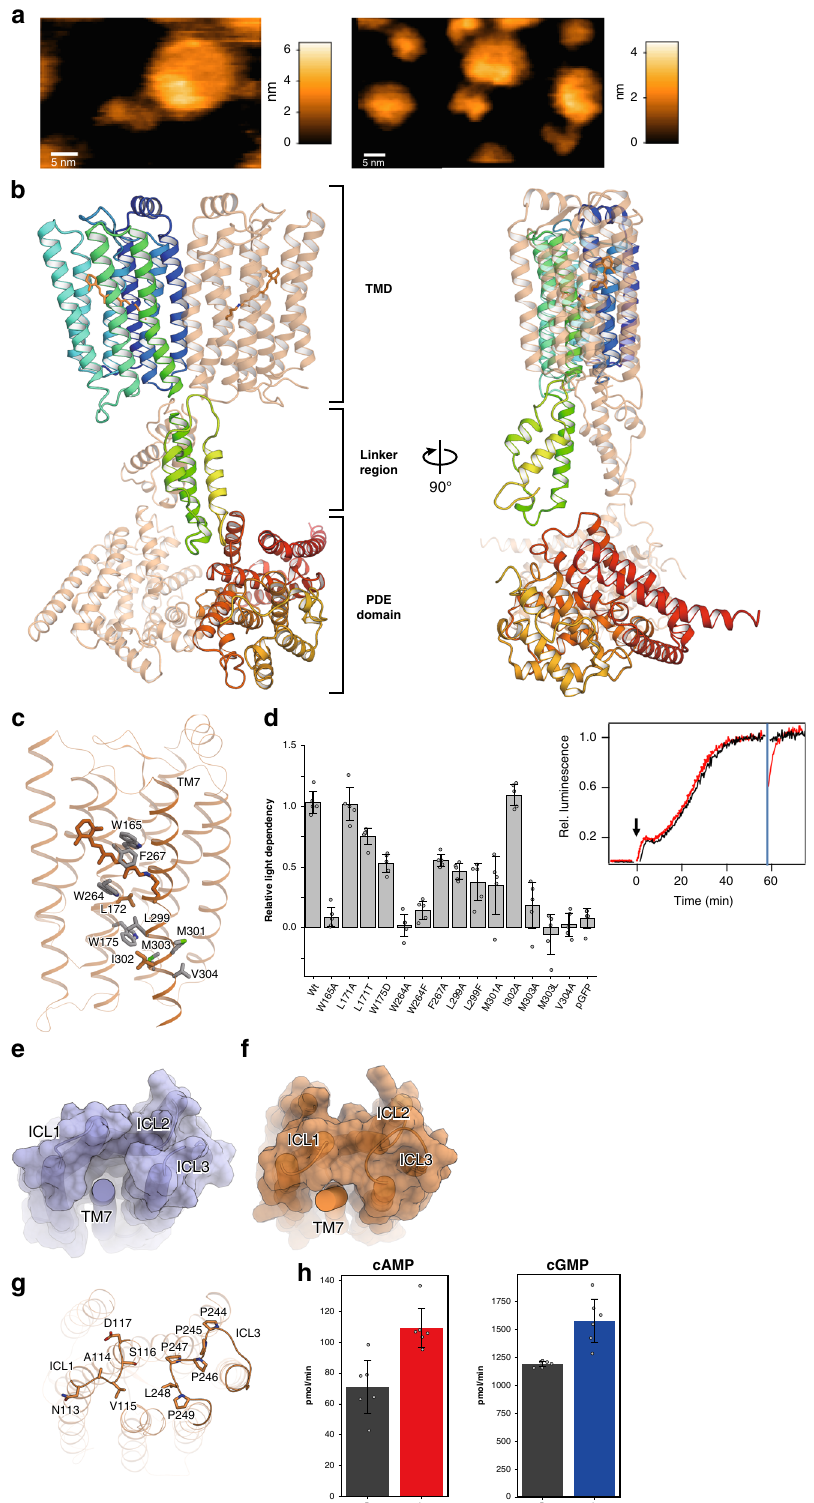
Fig. 5 Photoactivation mechanism of Rh-PDE. a HS-AFM images of the full-length Rh-PDE. b Ribbon diagrams of the full-length Rh-PDE model. One protomer is colored rainbow and the other is colored light orange. c Bulky residues between the intracellular side of TM7 and the retinal chromophore. d Relative activities of mutants, measured with a GloSensor assay. Data are presented as mean values± standard deviation (SD) ( n = 5 for I302A; n = 6 for the other, independent experiments). e , f Molecular surfaces of BR ( e ) and Rh-PDE ( f ), drawn without TM7. g Residues of ICL1 and ICL3 in Rh-PDE. h Photoactivities of the ICL3 mutant with cAMP (left) and cGMP (right). Data are presented as mean values ± standard deviation (SD) ( n = 6 independent